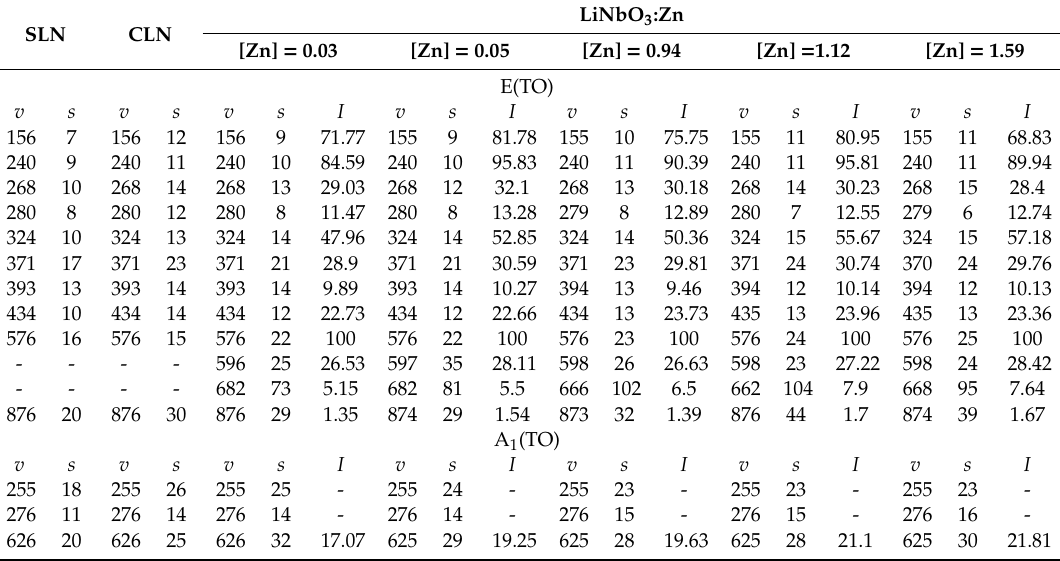
Figure 23. Raman spectra of SLN (1); CLN (2); LiNbO 3 :Zn, [Zn, mol.% ZnO] = 0.03 (3); 0.05 (4); 0.94 (5); 1.12 (6) and 1.59 (7) crystals in scattering geometries Y(ZX)¯Y ( a ) and Y(ZZ)¯Y ( b ). The figure is reproduced with the permission of Pleiades Publishing, Ltd. from the paper Opt. Spectrosc. 2014, V. 116, P. 281–290. doi:10.1134 / S0030400X14010202. Table 7. Basic parameters of bands corresponding to E (TO) and A 1 (TO) symmetry types oscillations in Raman spectra of SLN, CLN, and LiNbO 3 :Zn (0.03–1.59 mol.%).